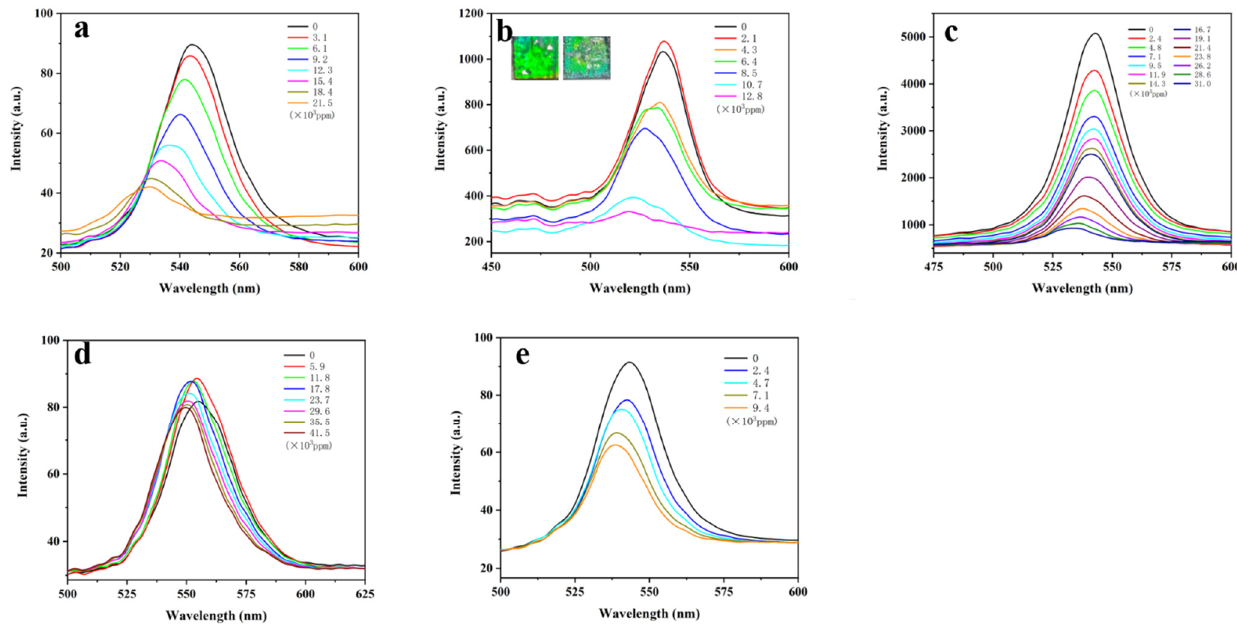
Figure 3. Response of photonic crystal hydrogel to methanol ( a ), ethanol ( b ), acetonitrile ( c ), acetone ( d ), and toluene ( e ) vapors.